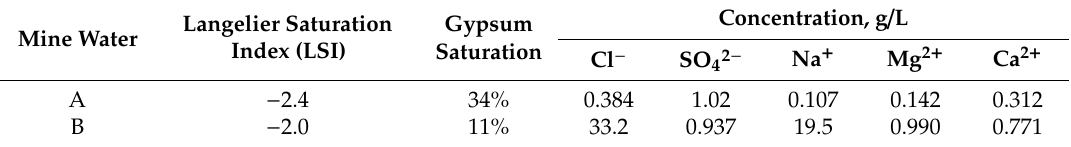
Table 1. Properties of the nanofiltration (NF) membranes were